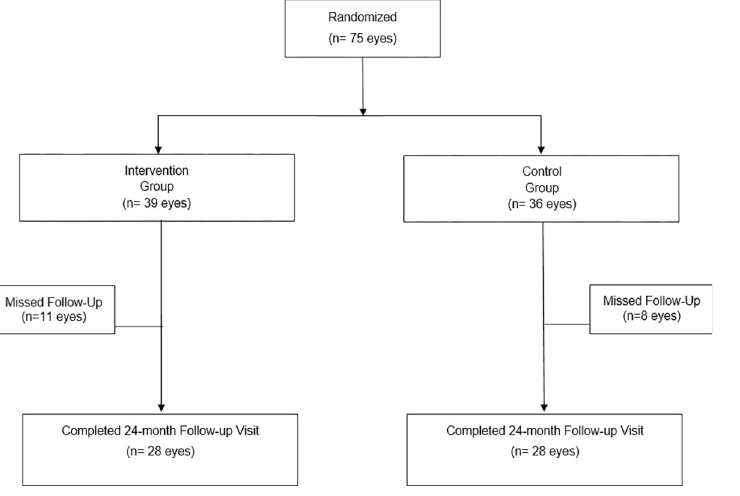
Fig 1. Flowchart of the participants’ progress in the study.